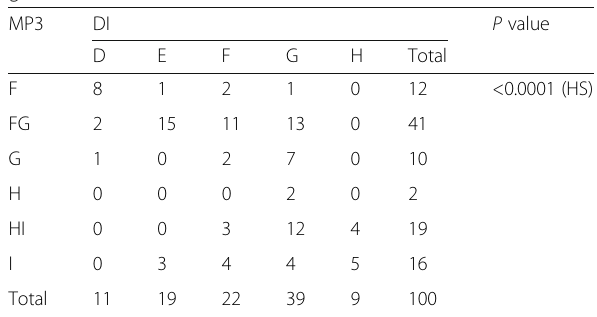
Table 1 Comparison between DI and modified MP3 (both